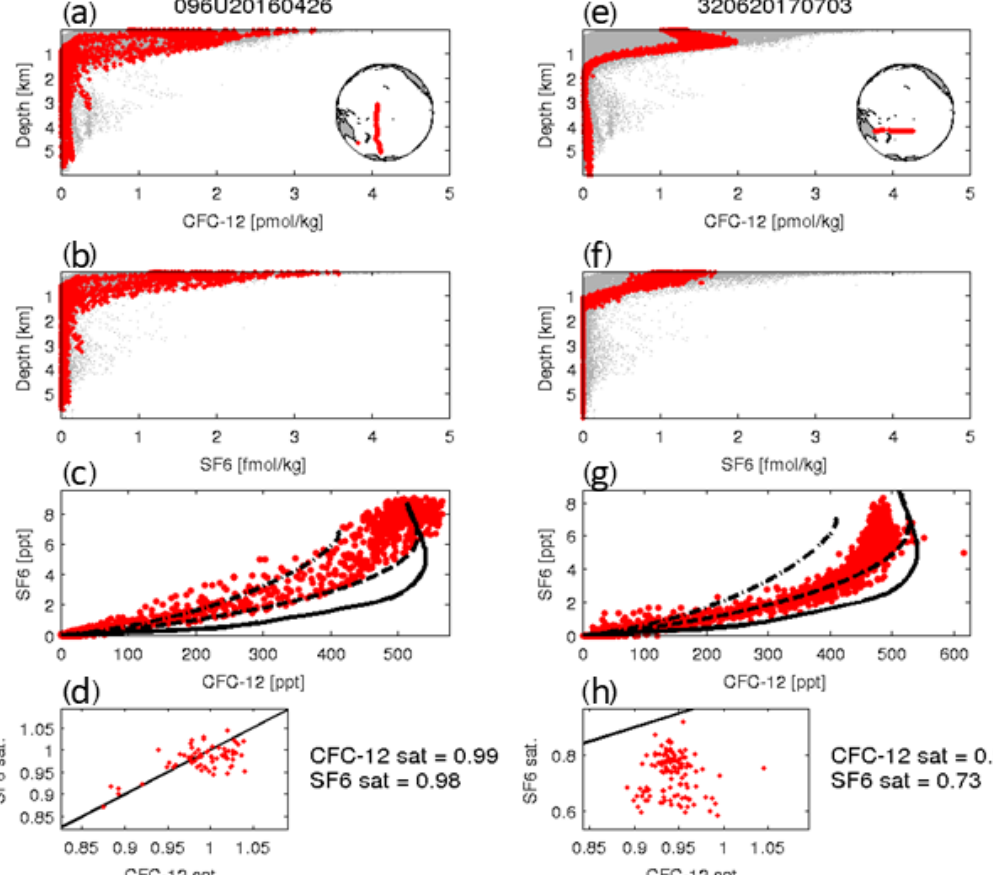
Figure 6. Example of plots used as basis for the SF 6 QC procedure. Shown are results for cruises 096U20160426 (left) and 320620170703 (right). (a, e) CFC-12 versus pressure for the specific cruise (red), together with all data from the corresponding GLODAP region (Pacific in this case, grey). (b, f) Same as upper row but for SF 6 . (c, g) CFC-12 versus SF 6 (red dots), here the measured contents have been converted into atmospheric mixing ratios. Solid black line: atmospheric time history of CFC-12 versus that of SF 6 . Dotted lines: CFC-12 versus SF 6 derived from the TTD method for two different sets of TTD parameters. (d, h) CFC-12 versus SF 6 saturation for the surface layer ( P < 20dbar), where the numbers give the mean saturation.